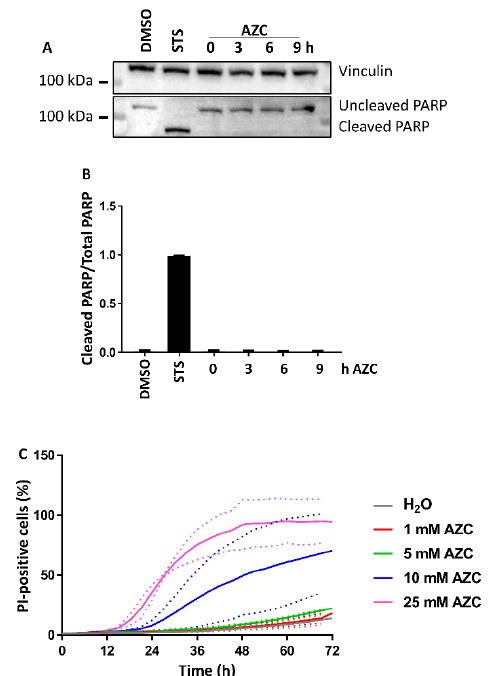
Figure 2. AZC does not induce cell death within 6 h of treatment. ( A ) A representative blot of six independent experiments each performed in duplicates showing protein levels of uncleaved and cleaved poly adenosine diphosphate ribose polymerase (PARP). Cells were treated for 6 h with DMSO or 1 μM staurosporine (STS) as control, or for 0–9 h with 5 mM AZC, and during the last 4 h 100 nM Baf A1 was added. Vinculin was used as loading control. ( B ) Quantification of PARP cleavage in ( A ) shown as mean ± SEM relative to 0 h AZC. ( C ) AZC induces cell death in a concentration-dependent manner only from 12 h of treatment. Cells were stained with 2.5 μg/mL propidium iodide (PI) and treated with 0–25 mM AZC for 72 h. Results are shown as average ± SEM (indicated by the dotted lines) of two experiments each performed in triplicate.